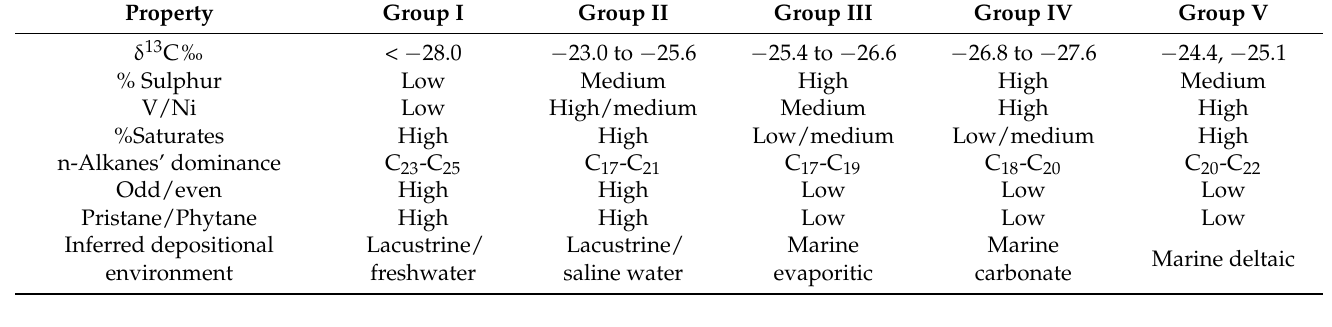
Table 2. Bulk and elemental properties of Brazilian offshore oils (Reproduced from [109] with the permission of Elsevier).